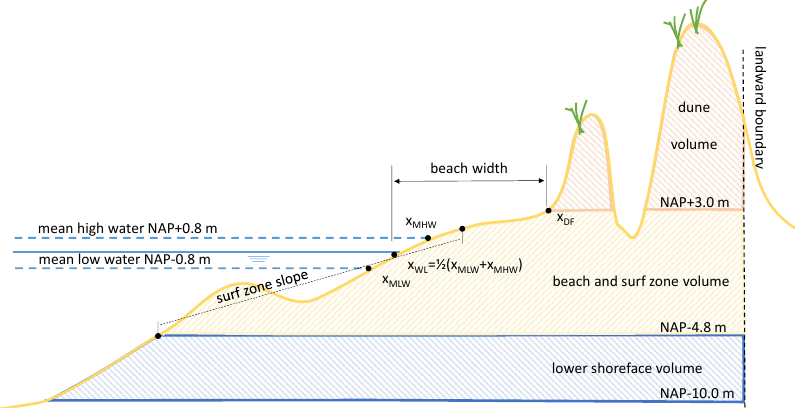
Figure 4. Schematic cross-shore profile to illustrate the various profile parameters extracted from the survey data. NAP is the Dutch reference level, roughly equal to mean sea